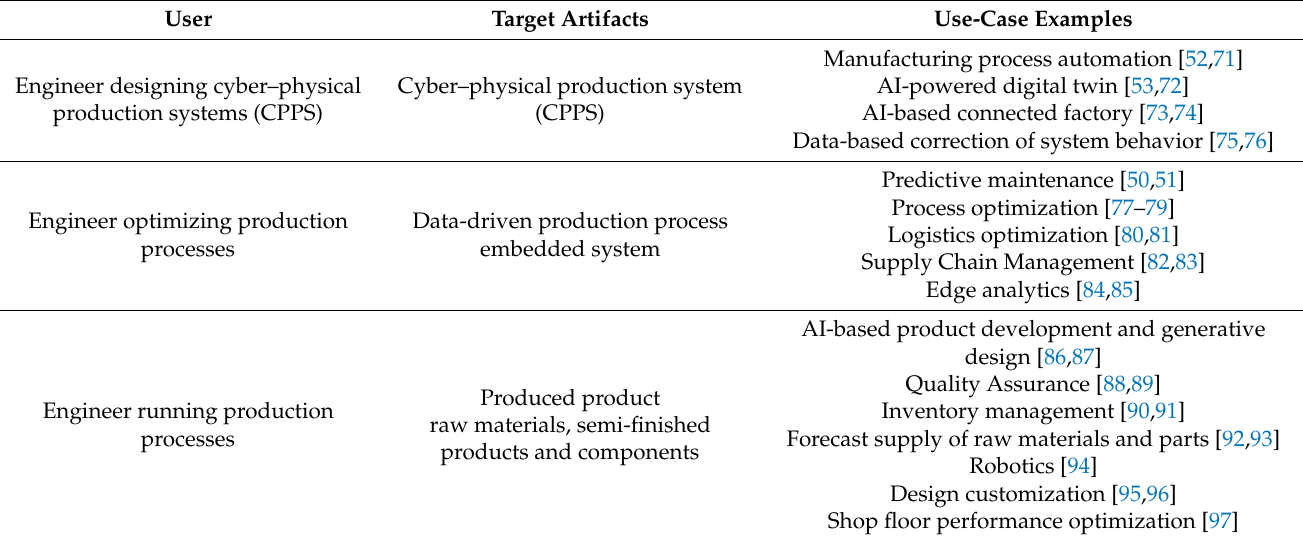
Table 6. Typical user roles in the production–engineering